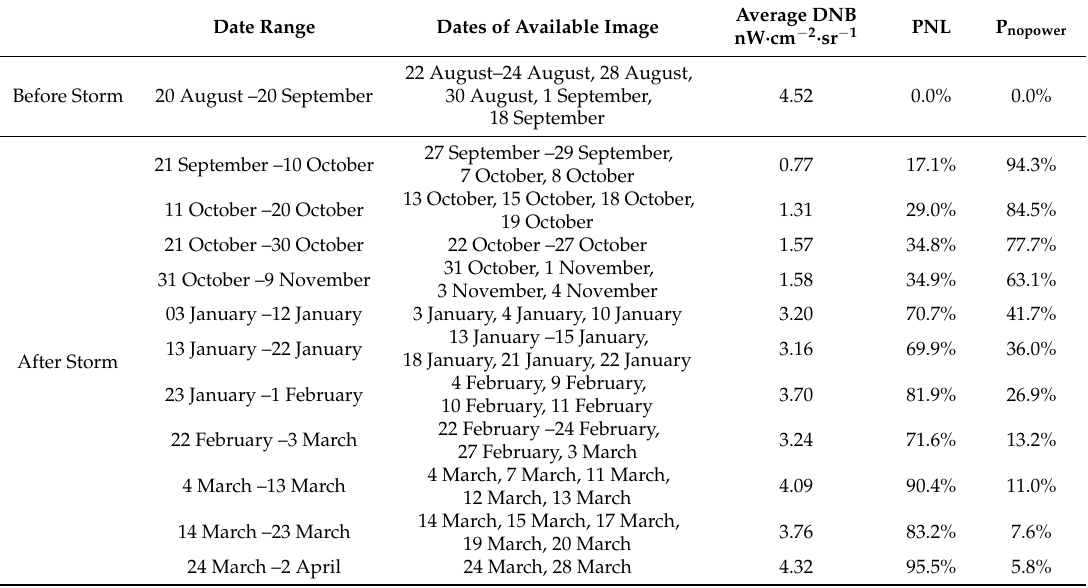
Table 7. The PNL and the percent of customers without power (P nopower ) values of Puerto Rico after Hurricane Maria.